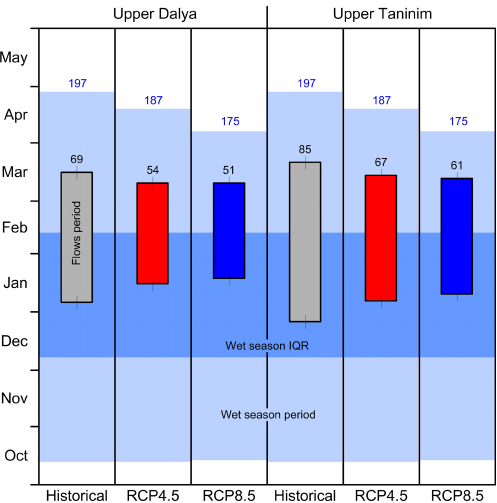
Figure 9. The period of the wet season (light blue, numbers repre- sent duration in days), its interquartile range (IQR, dark blue) and the streamflow season (central boxes, numbers represent duration in days) for upper Dalya and Taninim catchments for historical and future